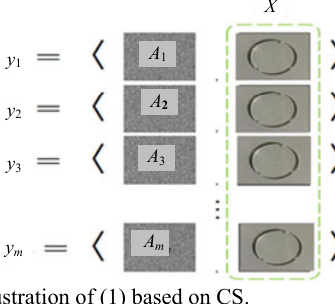
Fig. 1 Illustration of (1) based on